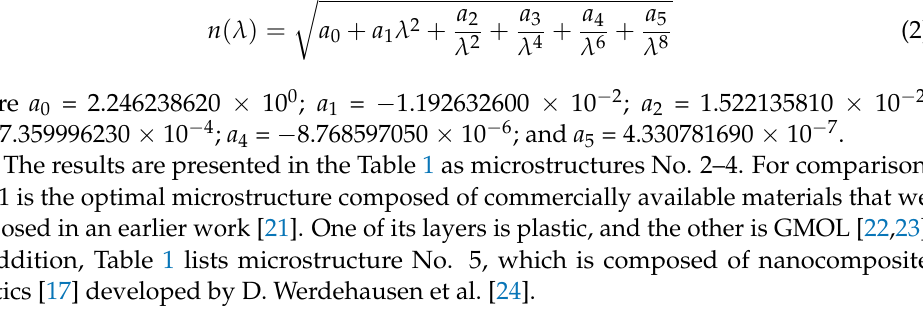
Table 1. Optimal two-layer single-relief